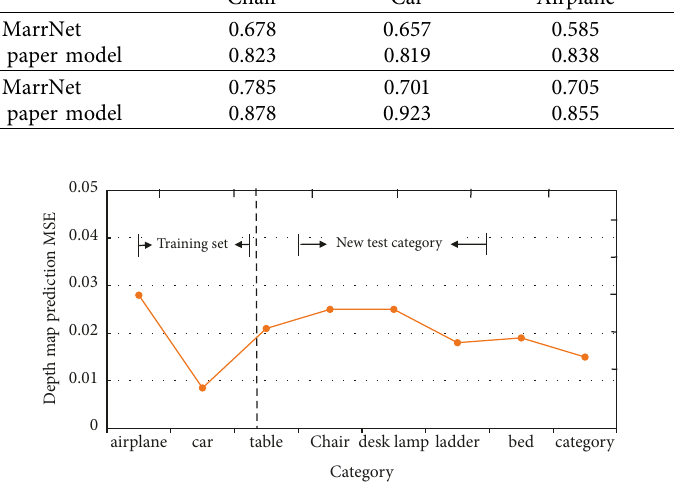
Figure 5: MSE values of prediction results for each category. Table 4: The test results of the chamfering distance of each model in the training set.